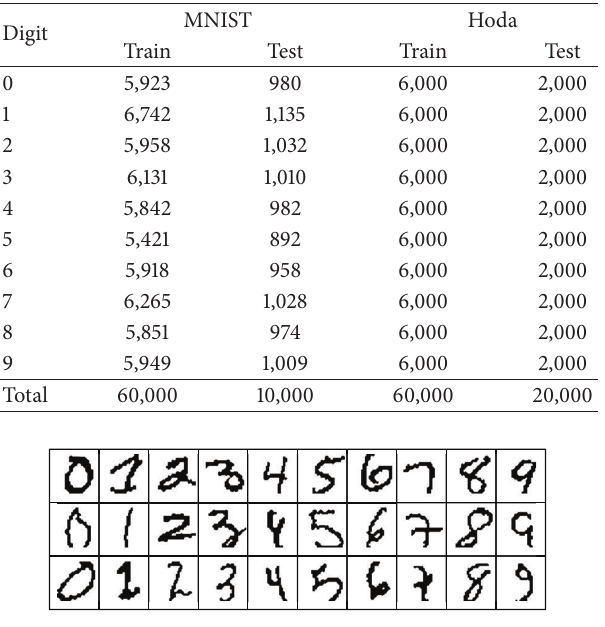
Figure 8: Some sample digits in the MNIST